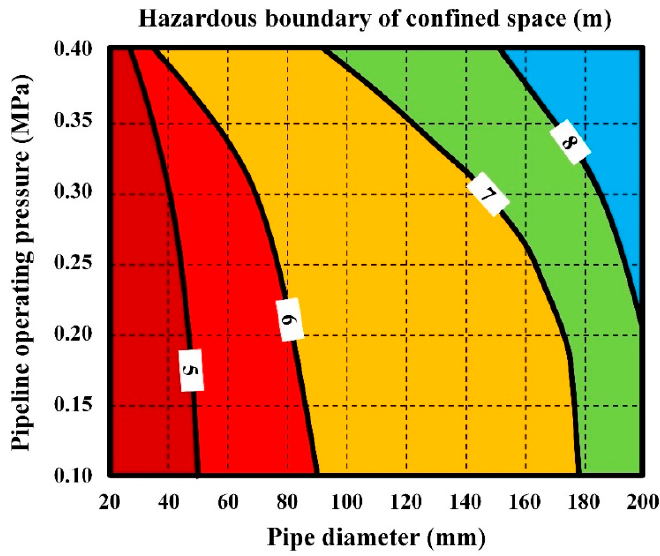
Figure 16. Hazardous boundary drawing